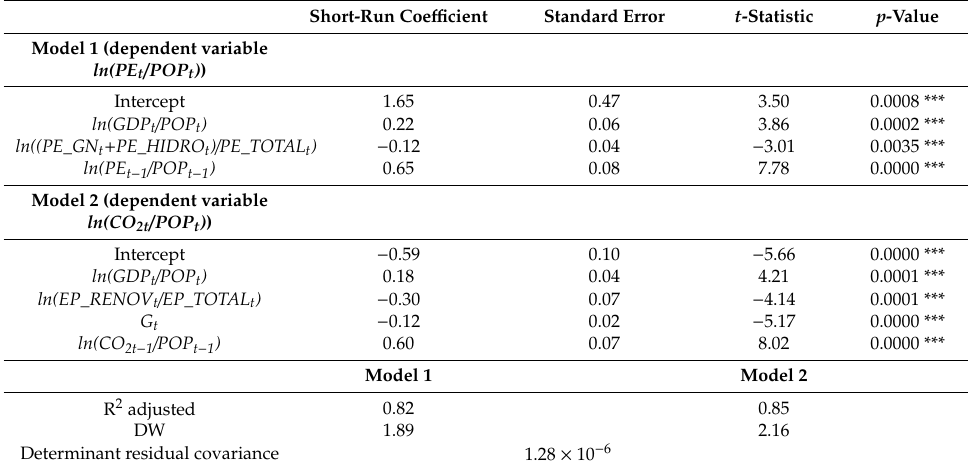
Table 2. Short-run estimates of the linear version of models 1 and 2.